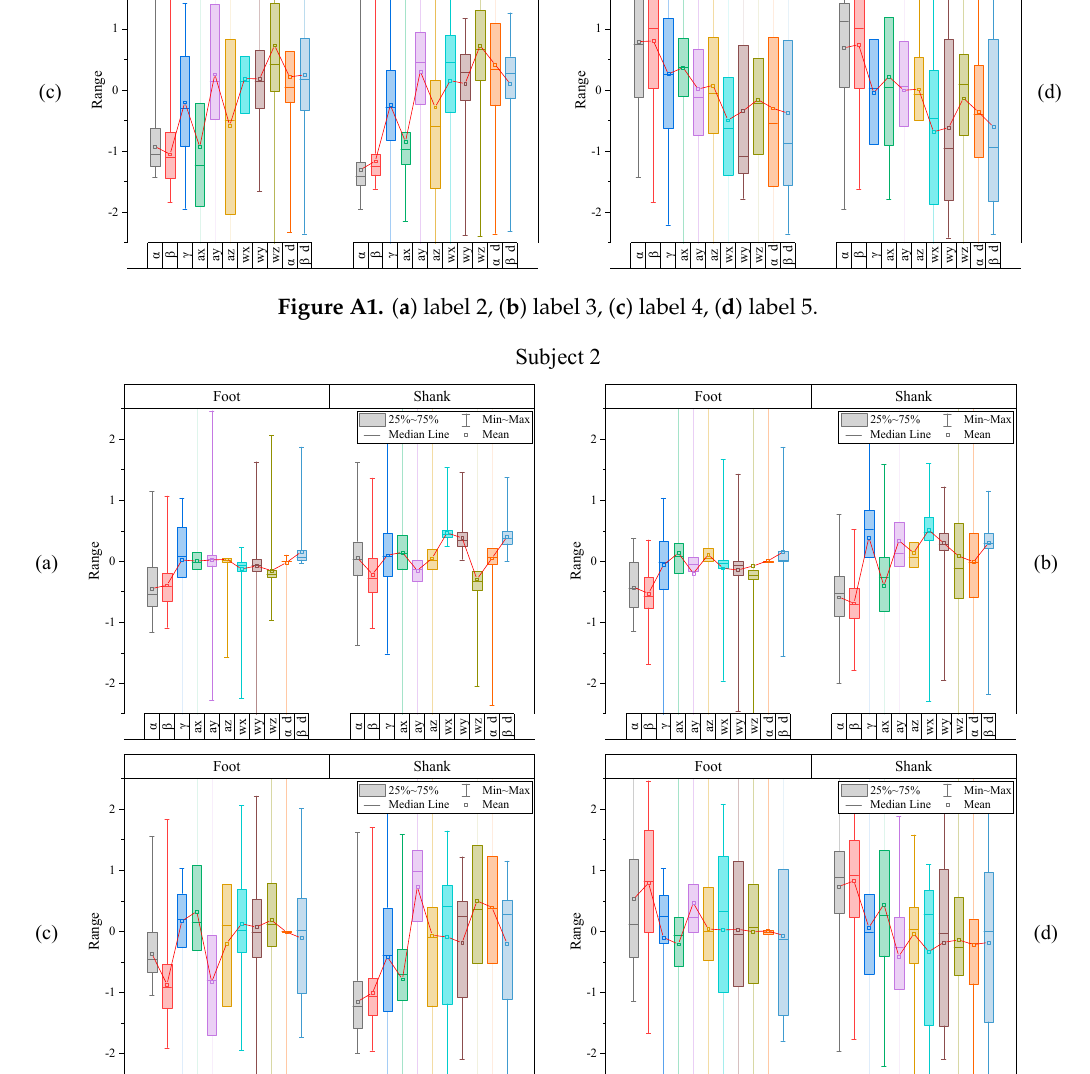
Figure A2. ( a ) label 2, ( b ) label 3, ( c ) label 4, ( d ) label 5.